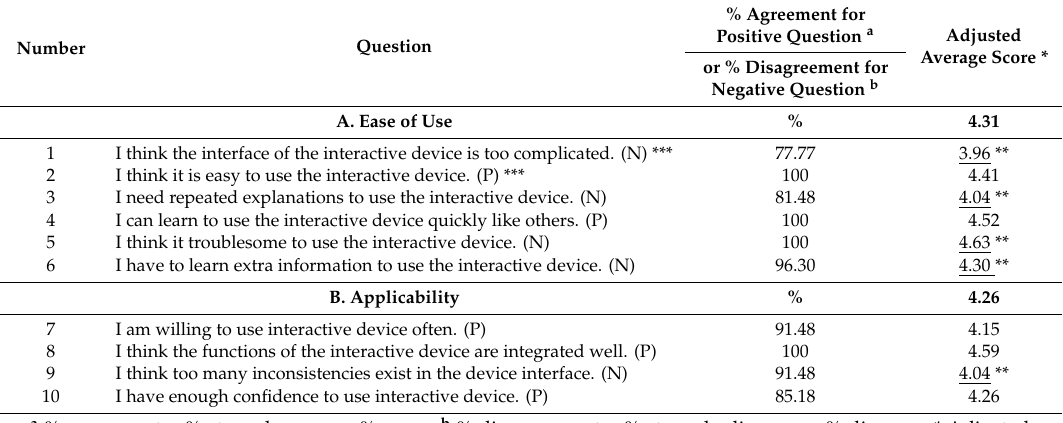
Table 4. Questions about system usability in the questionnaire and statistics of percentages and averages of the scores of the answers to the